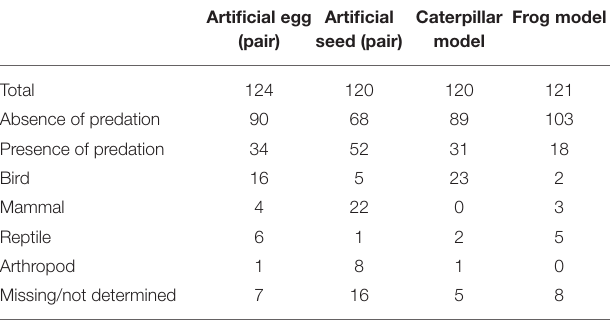
TABLE 2 | Number of artificial eggs, artificial seeds, caterpillar models, and frog models (excluding those tampered by humans) used in the predation experiments, and number of artificial prey items predated by birds, mammals, reptiles, and